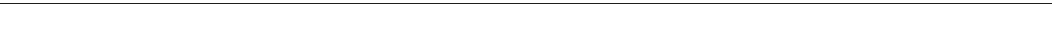
Fig. 6 SHP2 enhances TGF β -induced fi broblast activation via JAK2/STAT3. a mRNA levels of SHP2 after overexpression in human dermal fi broblasts. mRNA levels of COL1A1 in human fi broblasts transfected with empty vector, SHP2 WT - and SHP2 C459S -expression vectors, with or without TGF β 1 treatment (10 ng/ml for 24 h) ( n ≥ 4). b Western blot analysis and respective quanti fi cations for type I collagen and SHP2 in human fi broblasts transfected with empty vector, SHP2 WT - and SHP2 C459S -expression vectors, with or without TGF β 1 treatment (10 ng/ml for 24 h). Western blot for pJAK2 Y1007/Y1008 , pJAK2 Y570 , total JAK2, pSTAT3 Y705 and total STAT3 with β -actin as loading control (TGF β 10 ng/ml for 6 h) ( n = 3). Results shown are representative of three independent experiments. c , d Representative images of immuno fl uorescence stainings for α -SMA and stress fi ber staining are shown at 400-fold magni fi cation ( c ) and quanti fi cation of α -SMA staining intensity as well as stress fi ber staining intensity ( d ) ( n ≥ 4). Horizontal scale bar, 500 μ m. All data are presented as median ± s.e.m. The p values are expressed as follows: 0.05 > p > 0.01*; 0.01 > p > 0.001**; p < 0.001***. Signi fi cance was determined